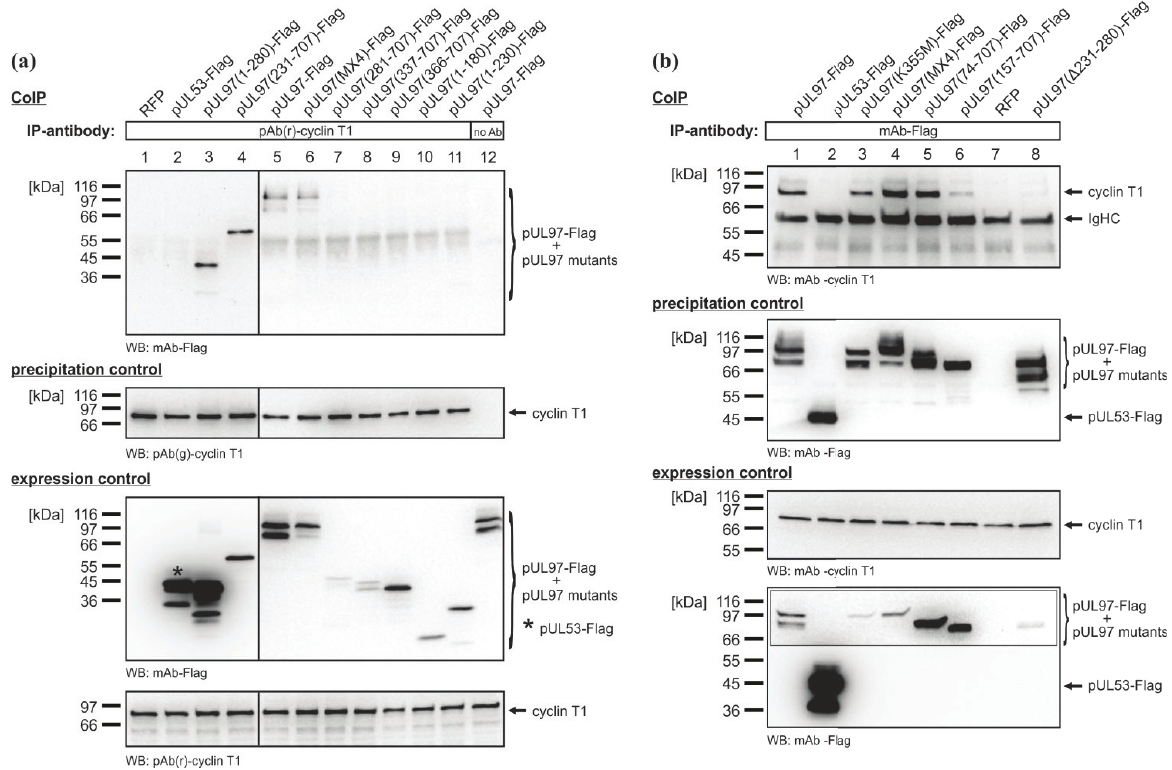
Figure 4. Mapping of the sequence domain of pUL97 responsible for the interaction with cyclin T1. Flag-tagged N- and C-terminal amino acid replacement and deletion mutants of pUL97 were transiently expressed in 293T cells. Recombinantly expressed RFP was used as the transfection control. At two days post-transfection, CoIP analyses were performed. Either ( a ) endogenous cyclin T1 was immunoprecipitated using pAb(r)-cyclin T1 or ( b ) Flag-tagged pUL97 mutants were immunoprecipitated using mAb-Flag. Specificity of precipitation was demonstrated by CoIP using Dynabeads® Protein A without antibody ( a , lane 12) and by the negative controls with recombinantly expressed pUL53-Flag ( a and b , lane 2). pUL97(MX4)-Flag, multiple amino acid replacement mutant carrying missense mutations in alternative start codons of pUL97 isoform expression: M38A, M74L, M111L and